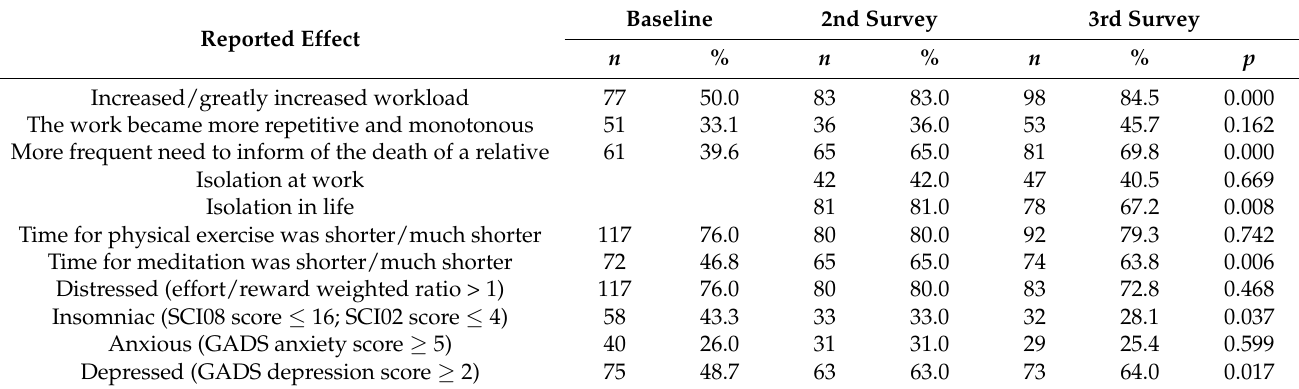
Table 2. Changes reported during the COVID-19 outbreak and prevalence of high stress, insomnia, anxiety, and depression during the 1st and 2nd waves.